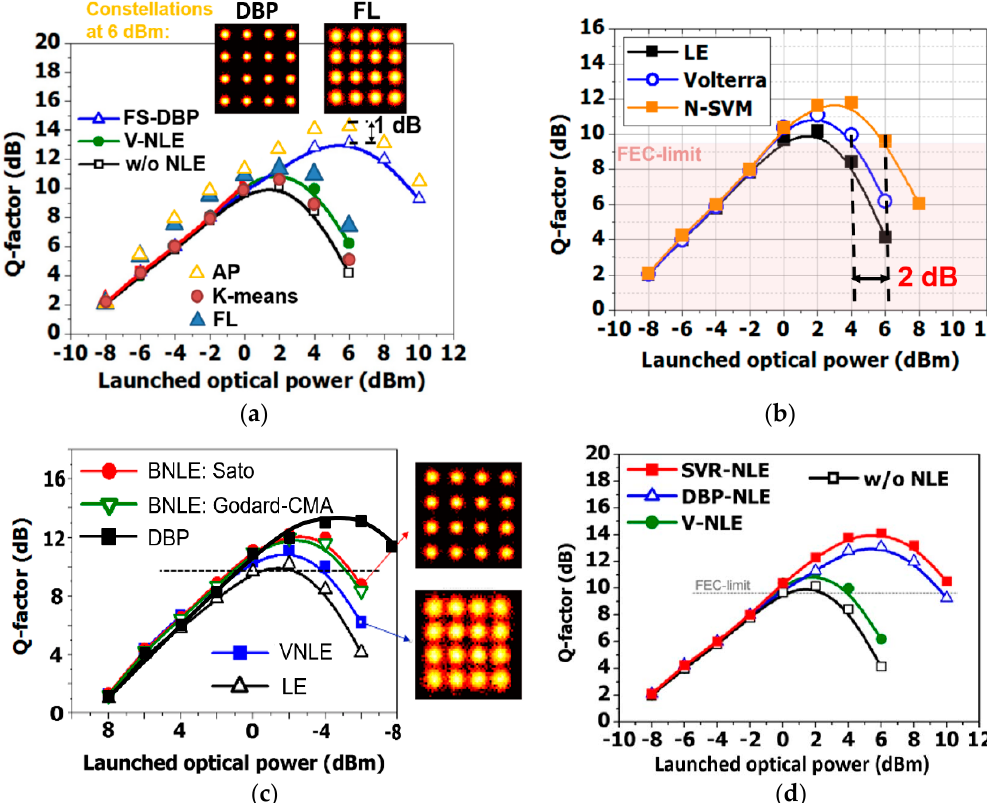
Figure 12. Single ‐ channel 16 ‐ QAM CO ‐ OFDM [21,28 ‐ 30,31,33,35,36] results in terms of Q ‐ factor vs. Figure 12. Single-channel 16-QAM CO-OFDM [21,28–31,33,35,36] results in terms of Q-factor vs. LOP for ( a ) clustering algorithms, ( b ) Fast ‐ Newton ‐ SVM (N ‐ SVM), ( c ) unsupervised SVMs and ( d ) LOP for ( a ) clustering algorithms, ( b ) Fast-Newton-SVM (N-SVM), ( c ) unsupervised SVMs and supervised SVM. ( d ) supervised